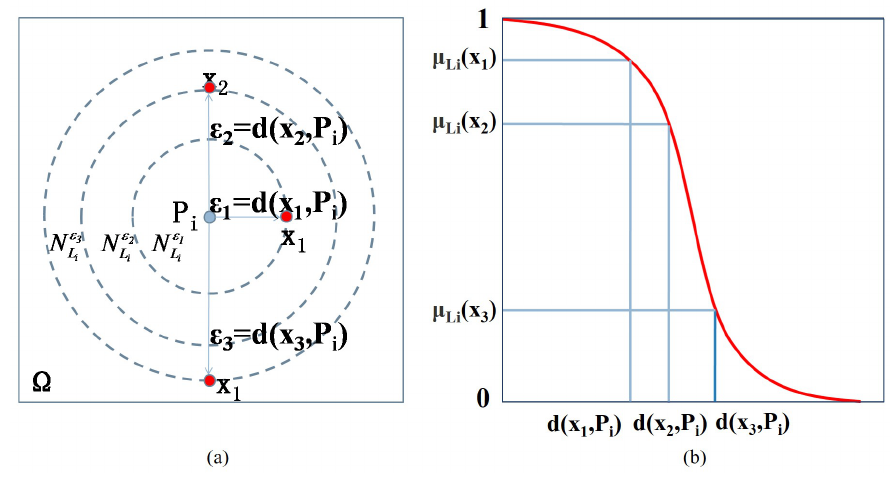
Figure 1. The illustration of a fuzzy semantic cell L i = (cid:104) P i , d , δ i (cid:105) in two-dimensional space Ω . ( a ) The fuzzy semantic cell L i = (cid:104) P i , d , δ i (cid:105) with the prototype P i and the uncertain neighborhood size (cid:101) . ( b ) The corresponding neighborhood function µ L